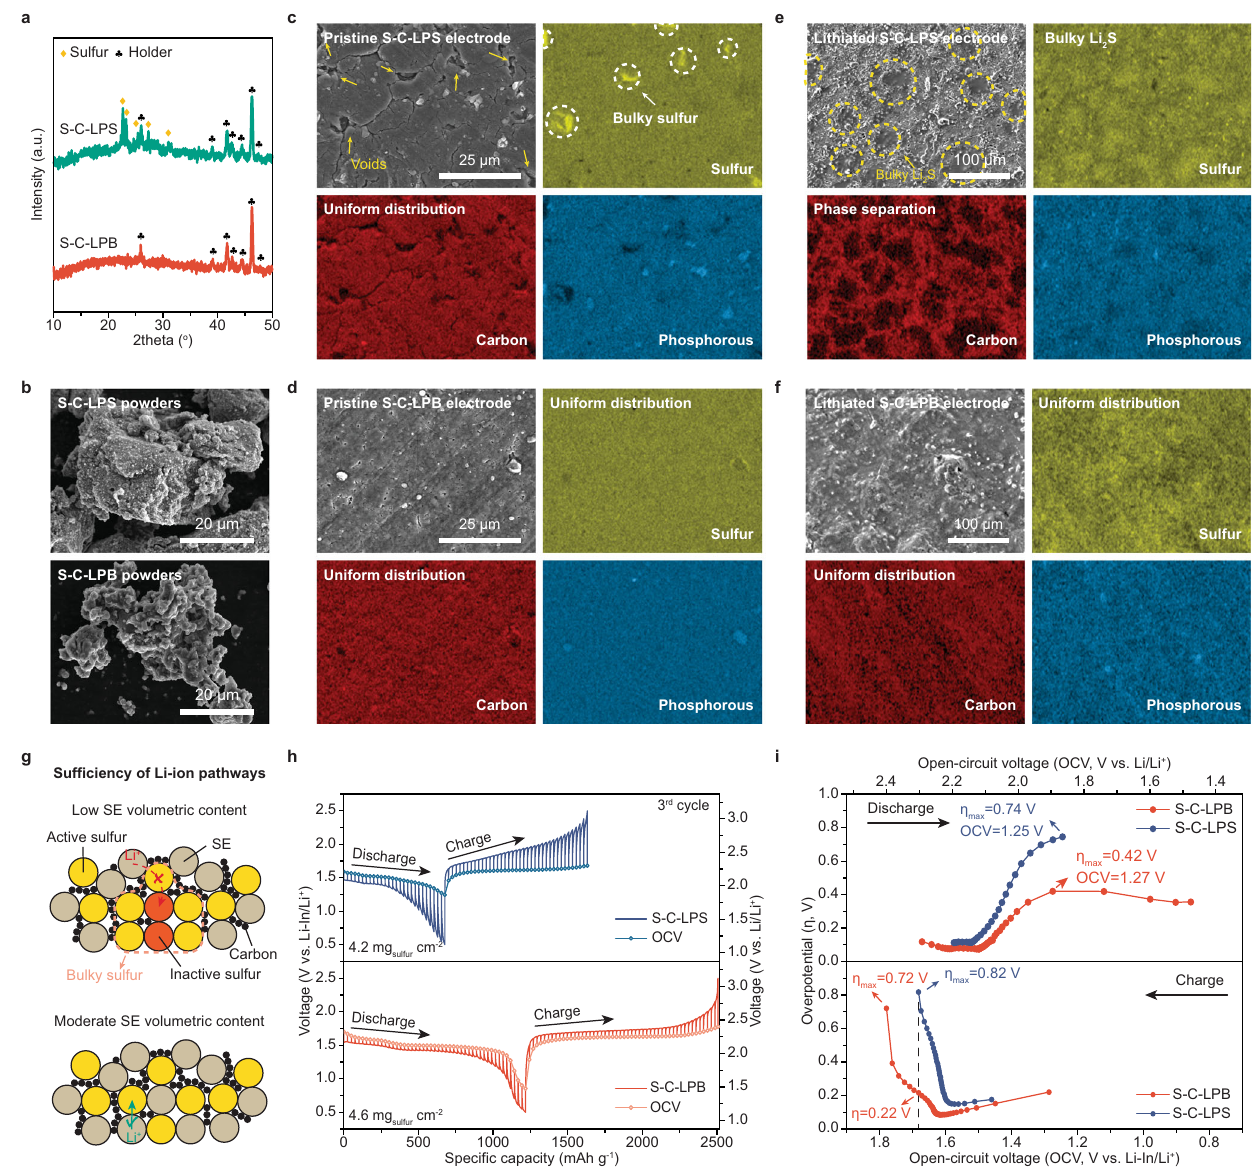
Fig. 4 | Physicochemical and electrochemical characterizations of the S-based positive electrode. a XRD patterns of S-C-LPS and S-C-LPB cathode powders. b SEM images of S-C-LPS and S-C-LPB cathode powders. c – f Ex-situ SEM and EDS mapping images of c pristine S-C-LPS cathode, d pristine S-C-LPB cathode, e lithiatedS-C-LPScathode,and f lithiatedS-C-LPBcathode. g Schematicillustration